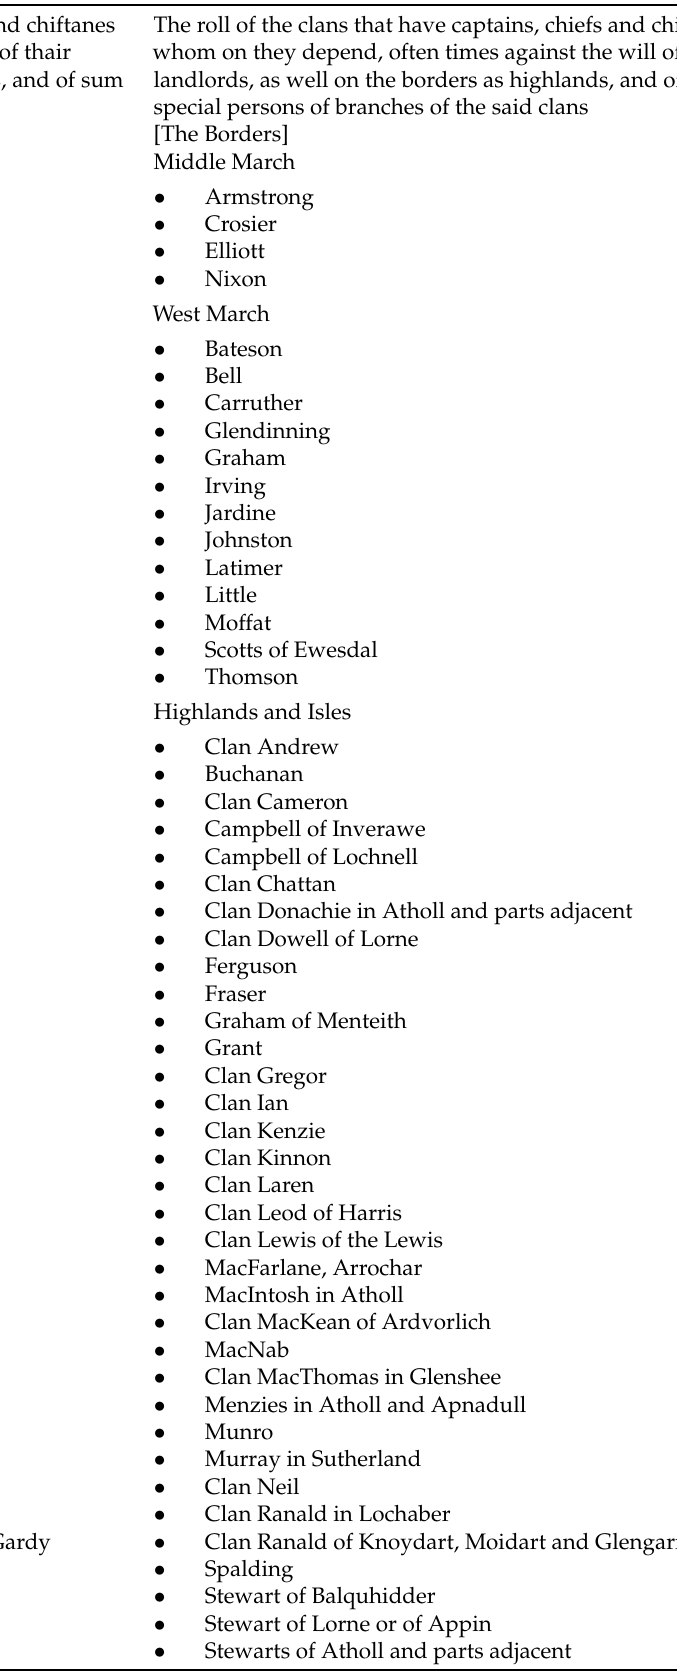
Table 1. The list of Clans in the Highlands and Borders felt to be